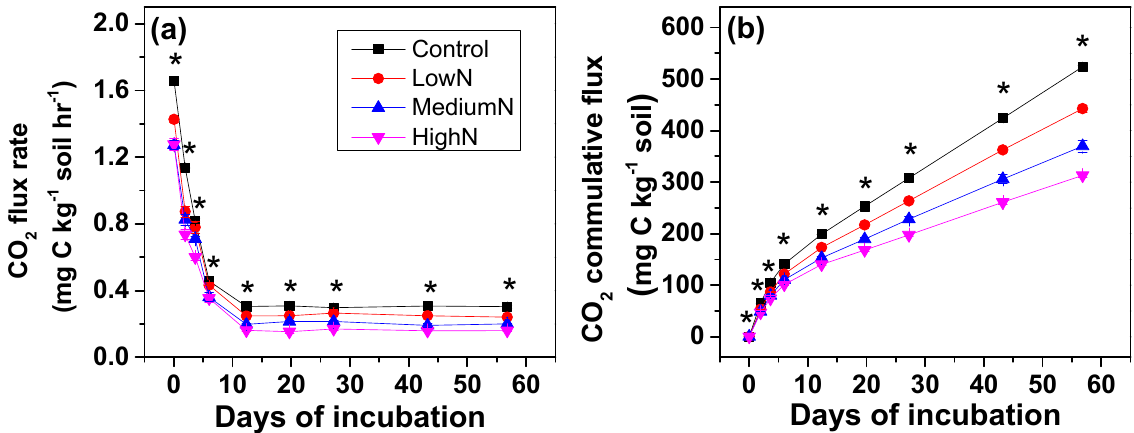
Figure 1. Effects of long-term N additions on soil organic carbon mineralization rate ( a ) and CO2 cumulative flux ( b ) in the N-rich mature tropical forest at Dinghushan reserve. Note: Asterisks (*) means significant differences between Controls and N treatments using planned-contrast analysis; values are shown as means ± standard error (n = 3); h means hour. Table 1. Responses of soil carbon mineralization, soil microbial biomass, and soil properties at 0–10 cm layer to long-term N additions in the N-rich mature tropical forest of Southern China.